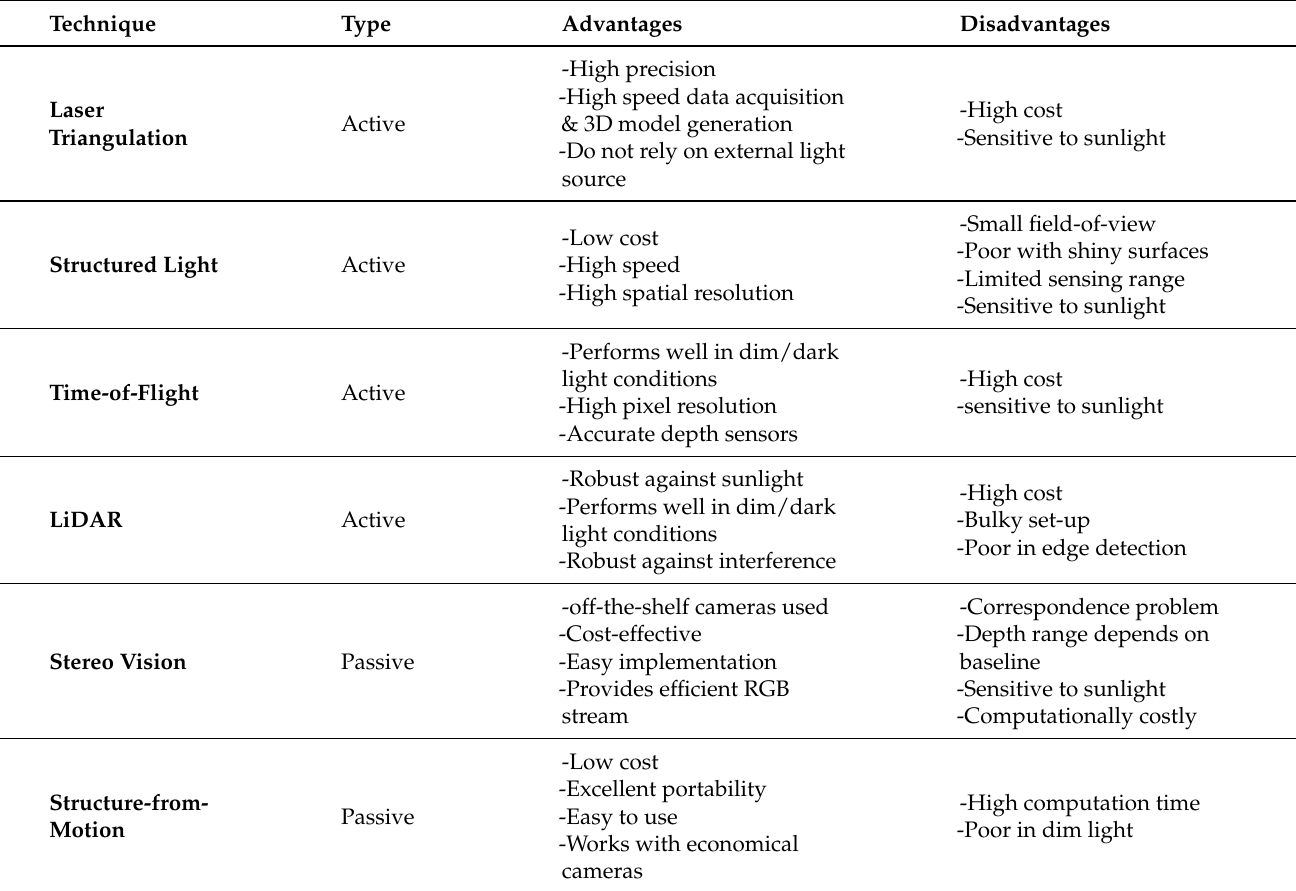
Table 2. Comparative analysis of 3D imaging